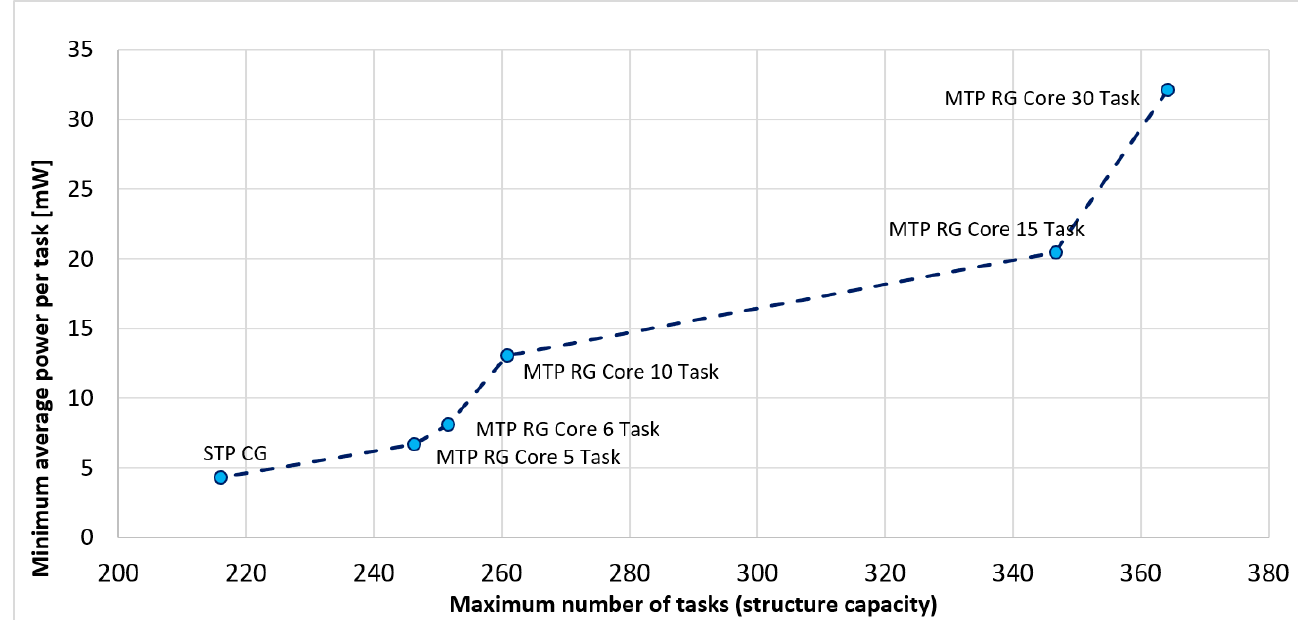
Figure 15. Comparison of the hypothetical structure capacity—estimation of the maximum number of tasks that can be executed in various scenarios (the system configurations).